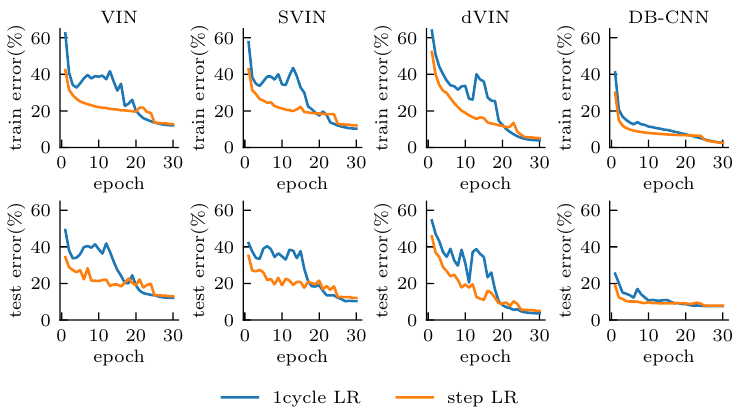
Figure 4. Training ( top ) and test error ( bottom ), with all models. The model trained with 1cycle LR converges better, although with a higher error in the early training stage. The dVIN has the best performance in the test set.